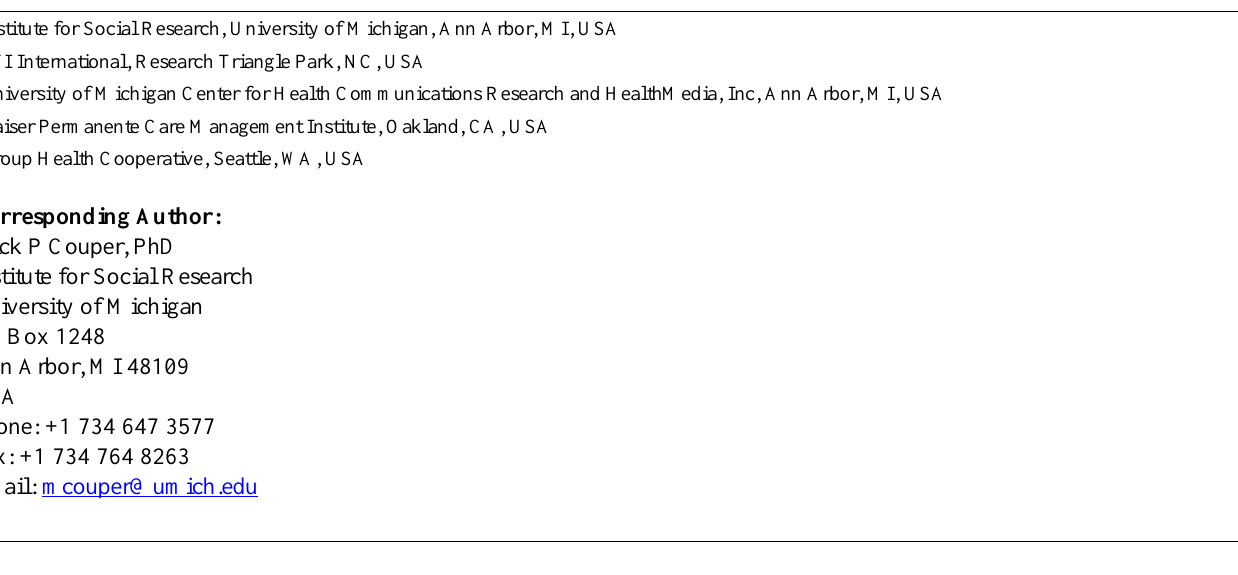
Nonresponse; attrition; Internet; weight management; randomized controlled